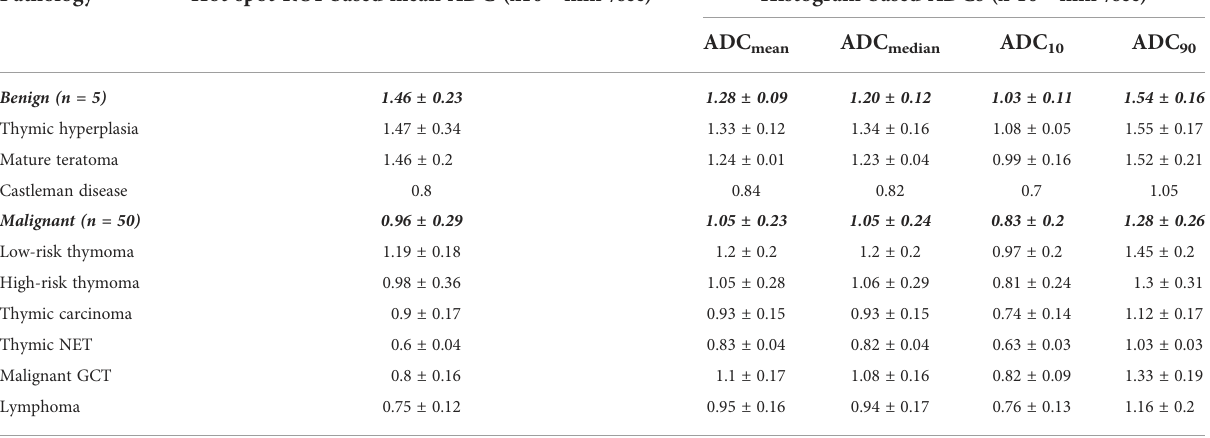
TABLE 3 Hot-spot-ROI-based and whole-tumor-histogram-based ADC measurements.